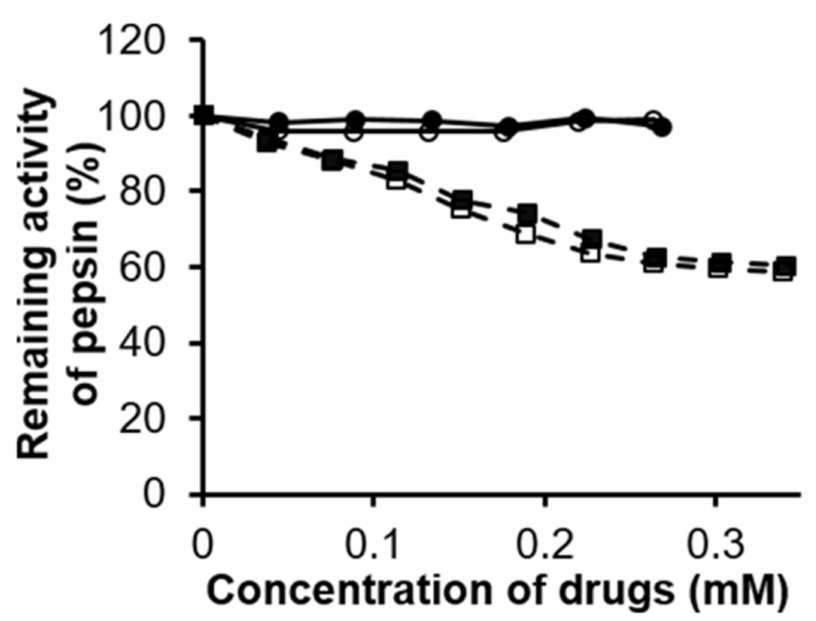
Figure 7. Pepsin inhibitory activity of free ARV and ARV@G3.0@mPEG. Empty circle: free 3TC, Solid circle: 3TC@G3.0@mPEG; Empty square: AZT, Solid square: